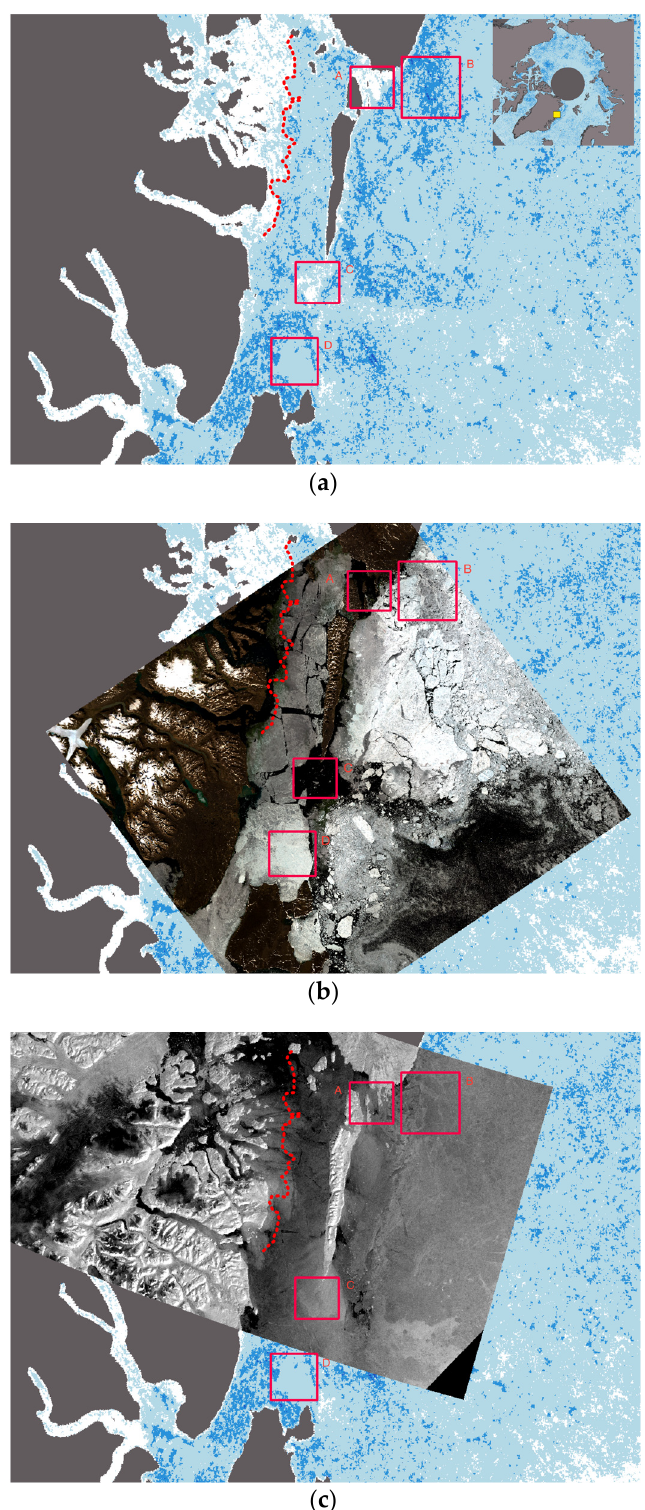
Figure 7. Comparison of ( a ) MISR-derived roughness map with ( b ) Landsat 8 for July 20th and ( c ) Sentinel-1 for July 19th images at an arbitrary location at the Fram Strait in July 2016 at 18.7 W and 76.5 N.